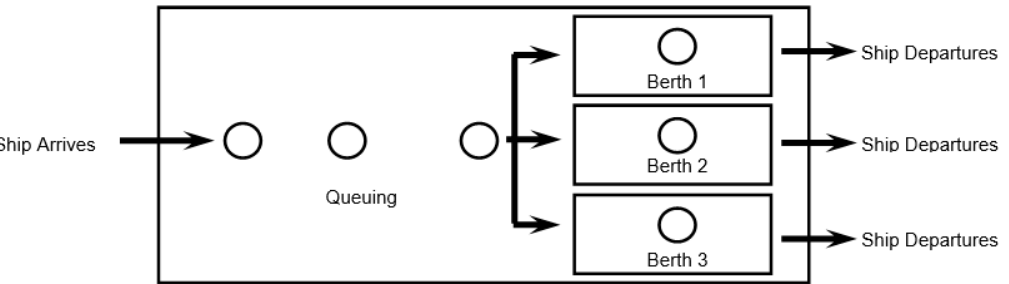
Figure 6. Berth queuing system